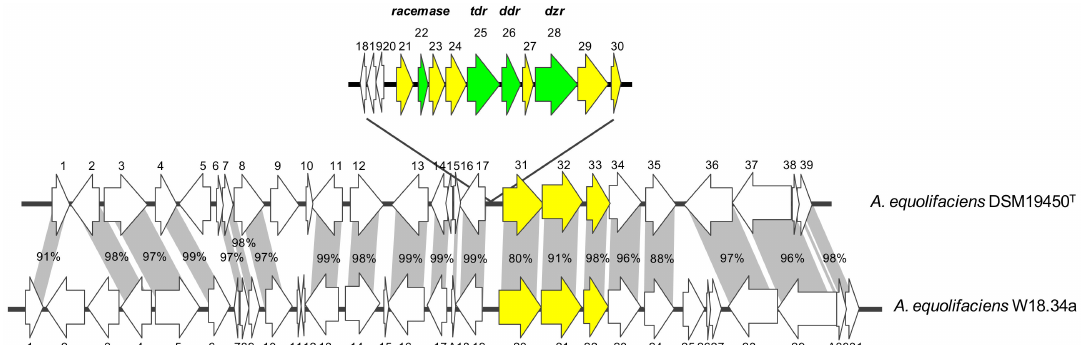
Figure 3. Diagram showing the genetic organization of upstream and downstream ORFs flanking the equol gene cluster in A. equolifaciens DSM19450 T and A. equolifaciens W18.34a, and the percentage of amino acid identity of the deduced proteins encoded by shared genes. In green, genes coding for the well-known proteins involved in equol biosynthesis racemase ( racemase ), daidzein reductase ( dzr ), dihydrogenistein reductase ( ddr ), and tetrahydrodaidzein reductase ( tdr ); in yellow, other genes within the equol biosynthesis